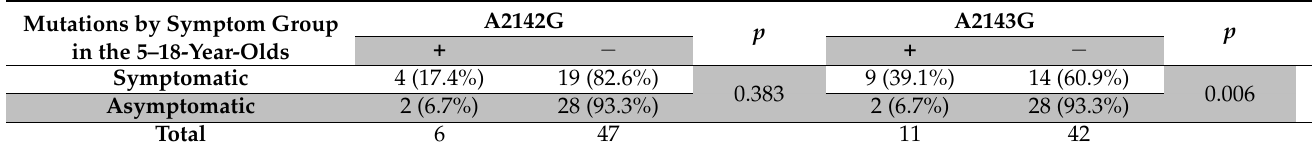
Table 7. The distribution of A2142G and A2143G mutations by symptom group in the 5–18-year-olds.